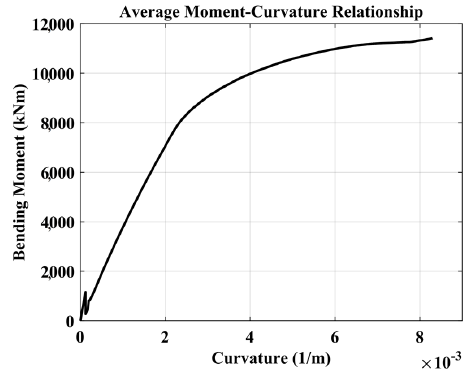
Figure 9. Computed “average moment ‐ curvature” relationship for B7 pile section.